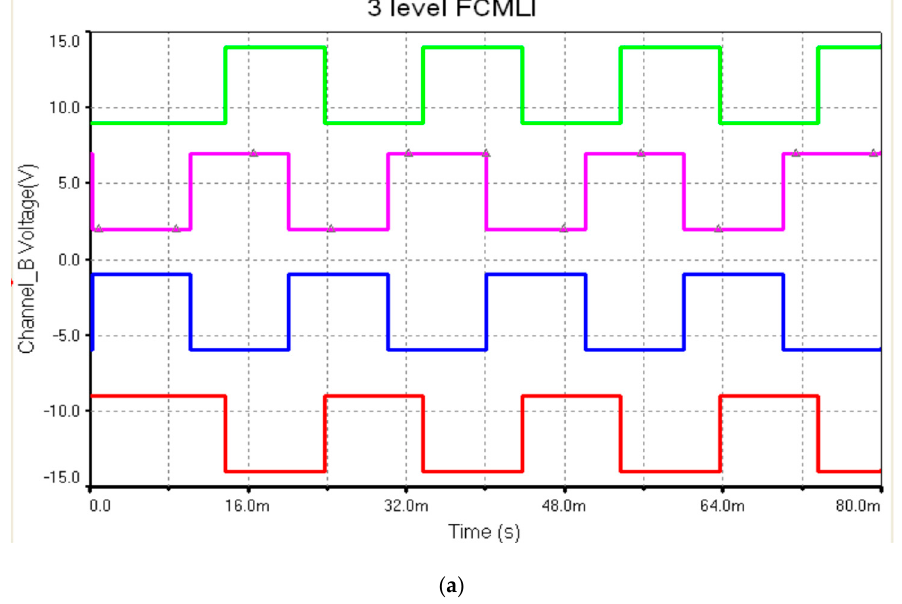
Figure 12. ( a ) Power circuit of 3-Level FC-MLI MULTISIM simulations; ( b ) control circuit of 3-level FC-MLI MULTISIM simulations.